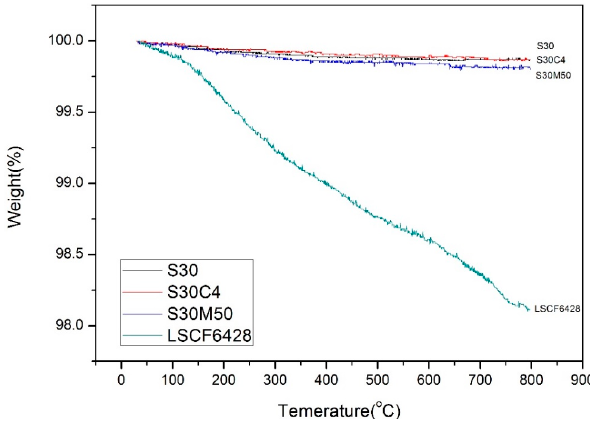
Figure 7. TGA curves of the S30, S30C4, S30M50 and LSCF6428 tested in air. Table 4. Molecular weight, mass loss and oxygen non-stoichiometry ( Δδ ) of S30, S30C4, S30M50 and Table 4. Molecular weight, mass loss and oxygen non-stoichiometry ( ∆ δ ) of S30, S30C4, S30M50 and LSCF6428 at 800 °C. LSCF6428 at 800 ◦